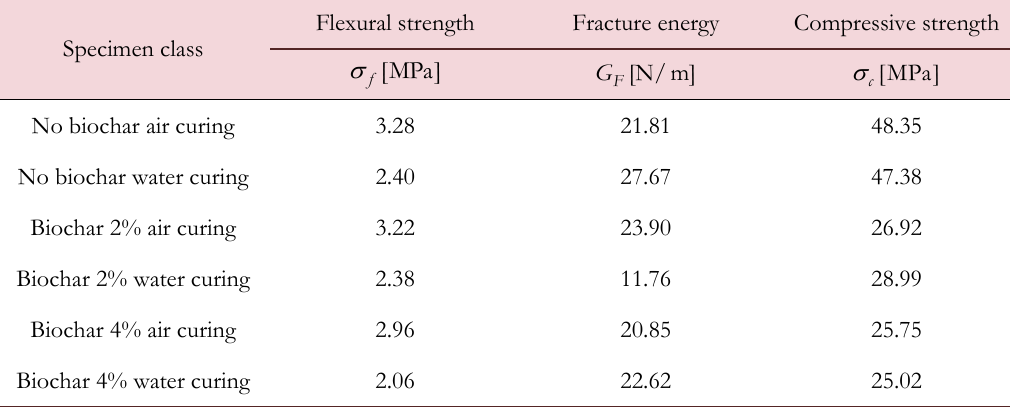
Table 1: Experimental results of analyzed specimens with different curing conditions and biochar contents.